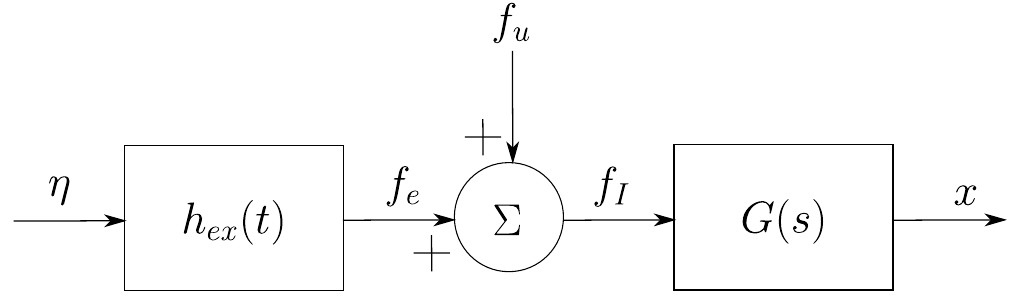
Figure 2. Forces applied to wave energy